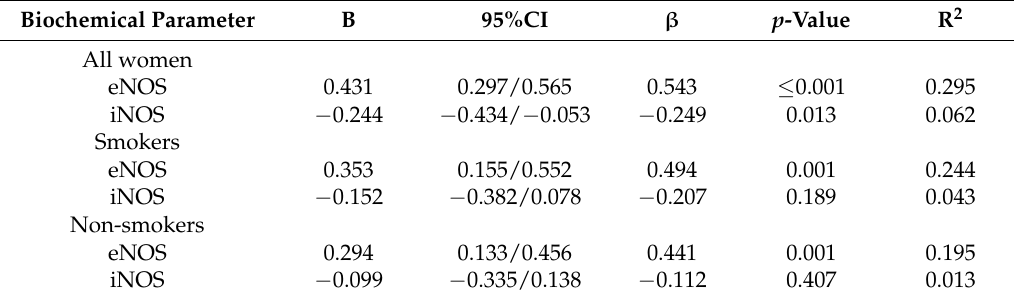
Table 3. Univariable regression analyses of NO with their synthases eNOS and iNOS in the whole group of studied women (n = 99) and in the subgroups of smoking (n = 42) and non-smoking pregnant women (n =